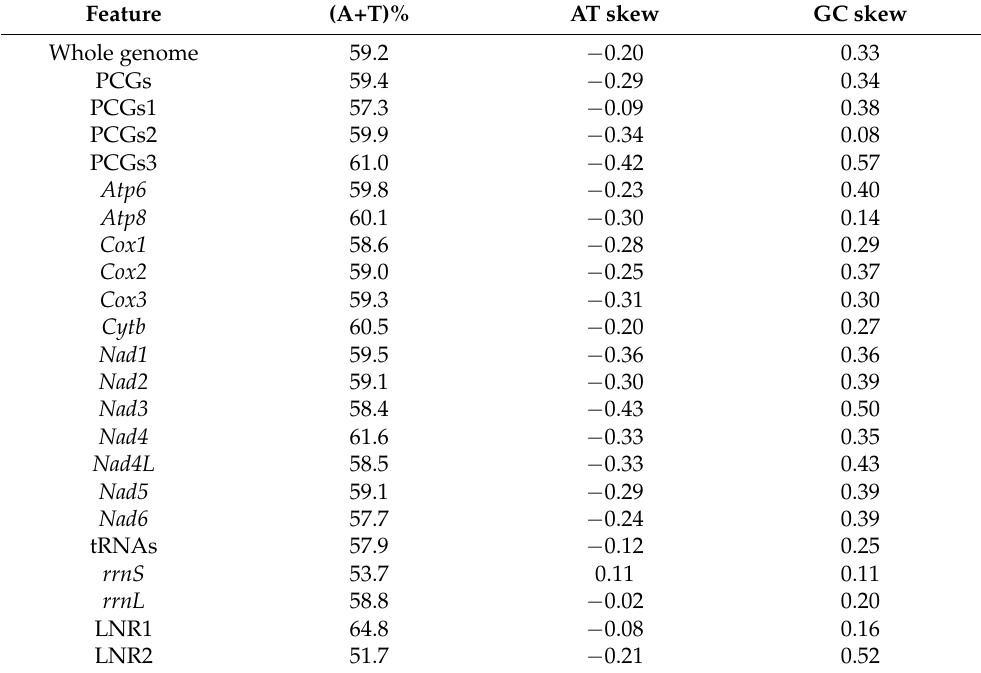
Table 3. List of AT content, AT skew, and GC skew of Hyotissa hyotis